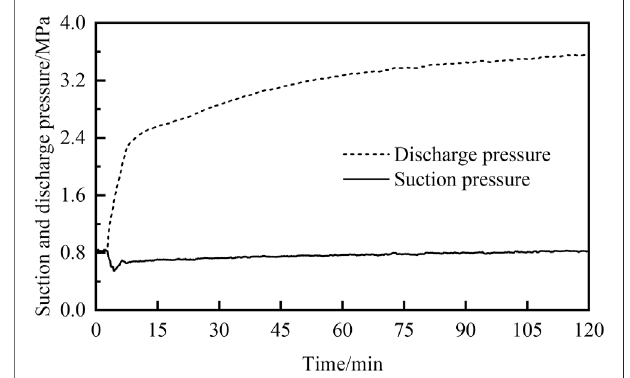
FIGURE 6 | Suction and discharge pressures during the system start-up.